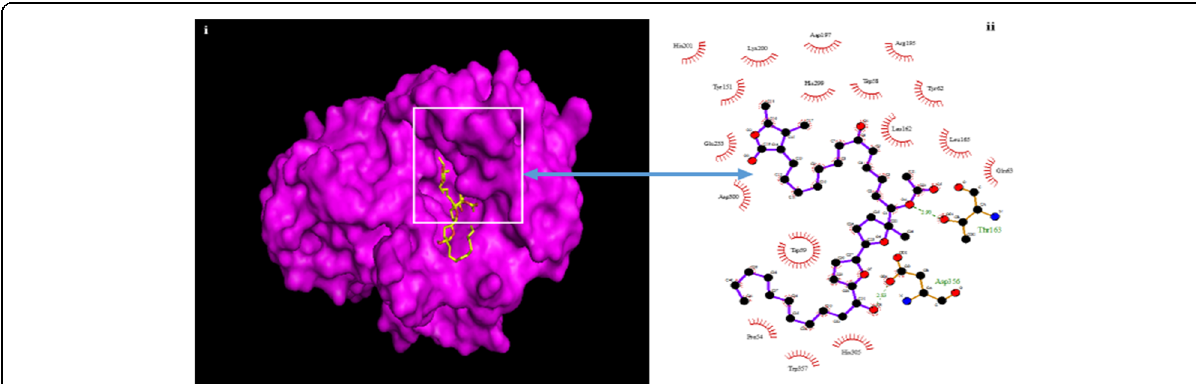
Fig. 16 The Binding pose of 15-acetyl guanacone at the active site of α -amylase with a binding energy of − 6.80 kcal/mole (i), and molecular interaction of 15-acetyl guanacone with amino acid residues within the active site of α -amylase (ii)